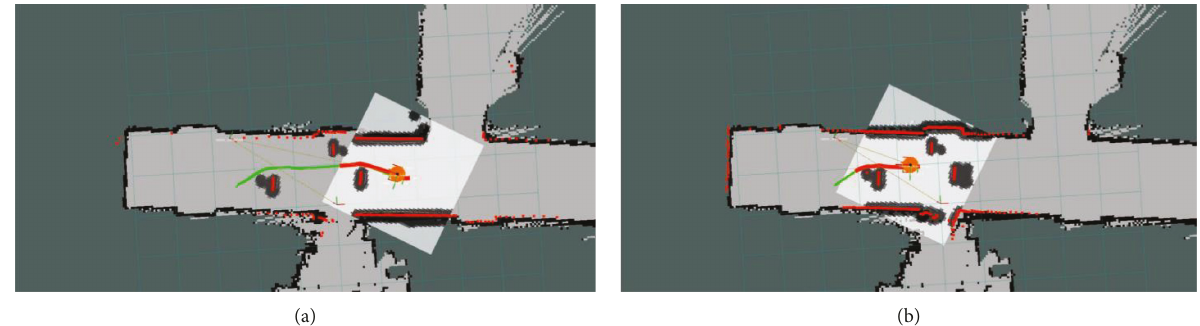
Figure 23: ROS simulation results. (a) Path planning. (b) Obstacle avoidance.